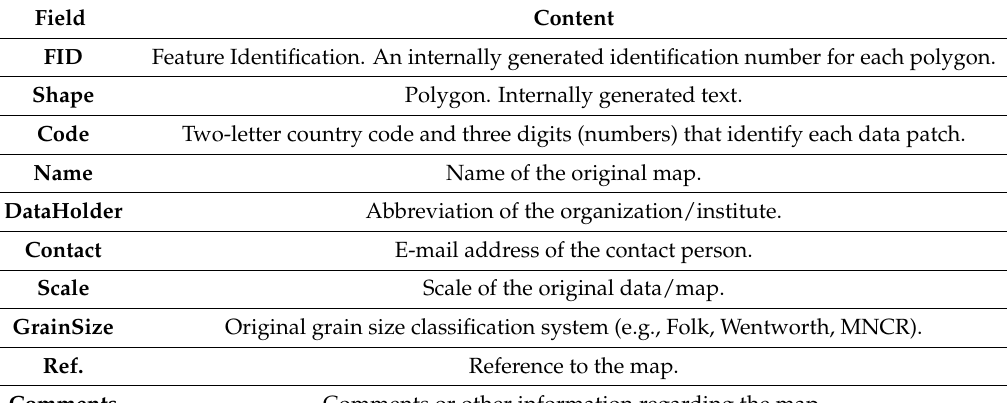
Table 1. The index shapefile/database includes an attribute table detailing basic information on each dataset.